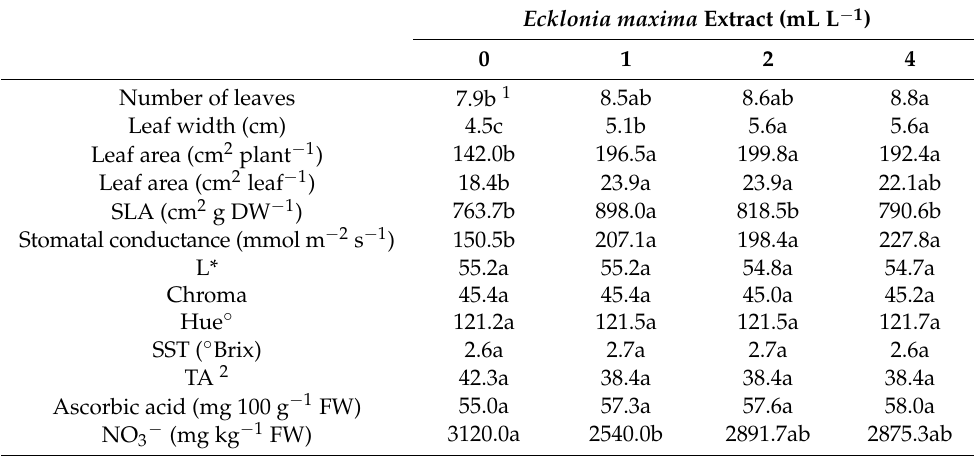
Table 2. Leaf characteristics of green leaf lettuce plants grown in nutrient solutions added with different concentrations of Ecklonia maxima extract.